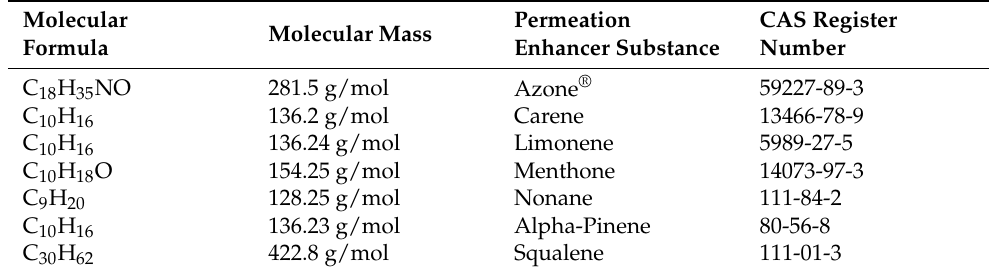
Table 1. Permeation enhancer used in this study.